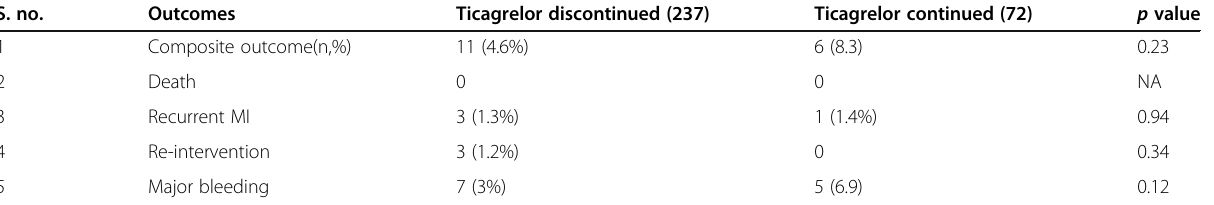
Table 3 Comparison of baseline characteristics between ticagrelor discontinued and ticagrelor continued arms. S. no.